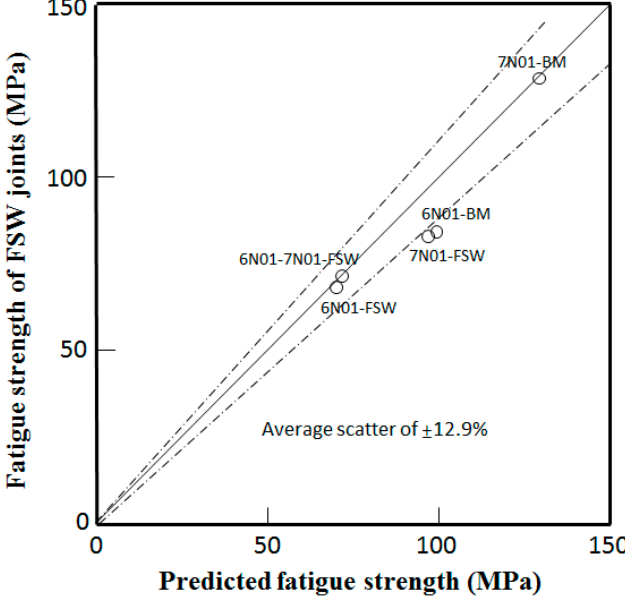
Figure 14. Relationship between fatigue strength predicted by Equation (5) and the experimental fatigue strength of FSW joints under R = 0.1.